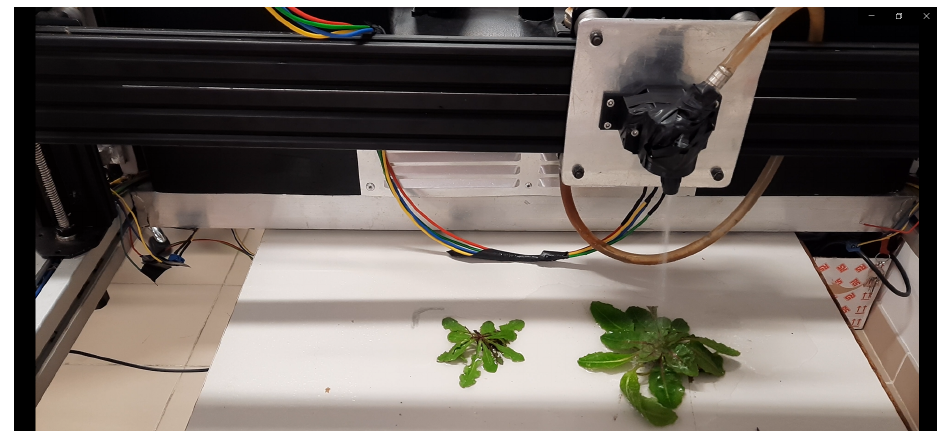
Figure 15. Result of real-time application: positioning of nozzle and spray